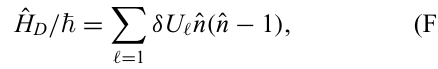
FIG. 7. The dynamics frozen by anharmonicity disorder and partial recovery via tuning of on-site energies in a chain of L = 6 transmons. (a) A single stack of bosons with the initial state | 3 2 (cid:3) . (b) Different size stacks with the initial state | 3 2 , 5 5 (cid:3) . On the left panels, we have the ideal, nondisordered case. The middle panels show the dynamics of a disordered chain. On the right, we add an on-site energy of ω (cid:3) = − 2 δ U (cid:3) , thus approximately restoring the nondisordered